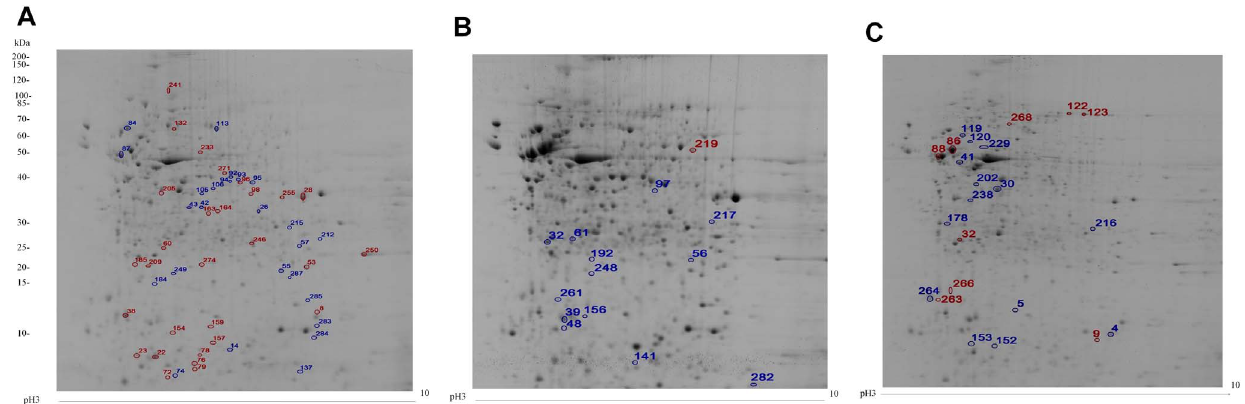
Figure 4. Protein profiling of f-rES (A), fibroblast (B), and p-rES cells (C) grown to log phase. A total of 1,000 m g soluble proteins were TCA precipitated and separated by IEF using 180 mm IPG DryStrips at pH 3–10, followed by 12.5% SDS-PAGE gels. Proteins were visualized by colloidal Coomassie blue staining. Spots with higher expression levels are circled and numbered in red, and those with lower expression levels circled and numbered in blue.